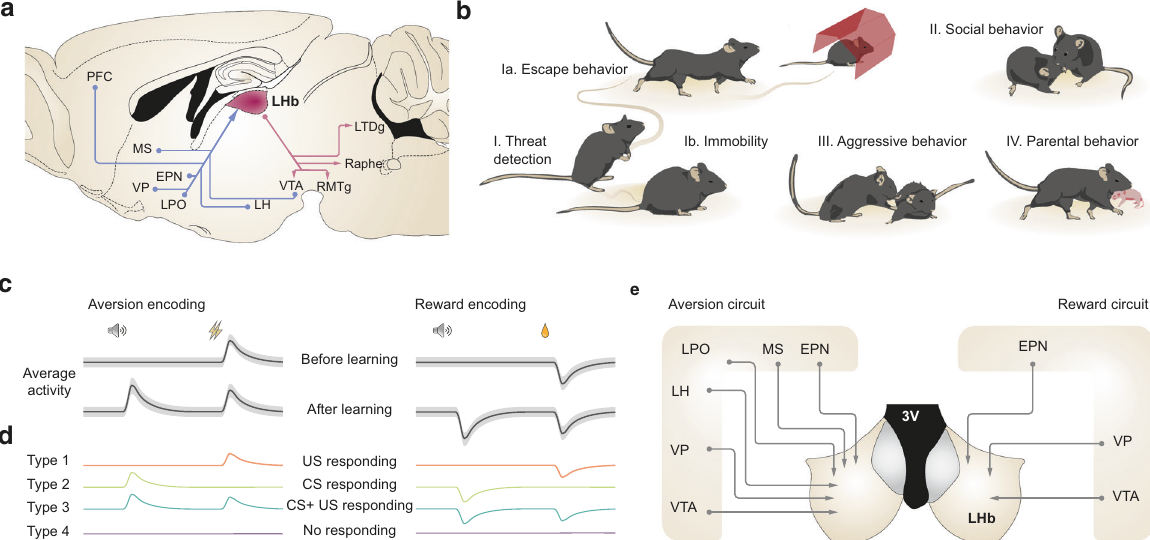
Fig. 1 The LHb guides innate and learned behaviours by encoding rewarding and aversive stimuli through complex circuit connectivity and diversity in neuronal responses. a Schematic representing the principal LHb inputs (blue) and outputs (purple) contributing to innate and learned behaviours. Ventral tegmental area (VTA), lateral hypothalamus (LH), lateral preoptic area (LPO), ventral pallidum (VP), entopeduncular nucleus (EPN), medial septal nucleus (MS) and Prefrontal Cortex are projections to the LHb. LHb neurons send axons to VTA, Rostromedial Tegmental Nucleus (RMTg), Raphe and Laterodorsal Tegmental nucleus (LDTg). b Schematic representation of various innate behaviours that are controlled by LHb. Response to a threat (I.) and subsequent escape behaviour (Ia.) or immobility (Ib); social interactions (II.), aggressive interactions (III.) and parental behaviours (IV.). c Illustration of the average neuronal activity of LHb cells in response to a conditioned stimulus and unconditioned aversive and rewarding stimulus before and after associative learning. d Tentative model representing the neuronal and functional diversity present during the encoding of conditioned stimuli and unconditioned stimuli. Such a neuronal diversity is represented by the type I (orange), II (green), III (blue) and IV (purple). e Key inputs onto the LHb that contribute to the encoding of unpredicted and predicted aversive and appetitive